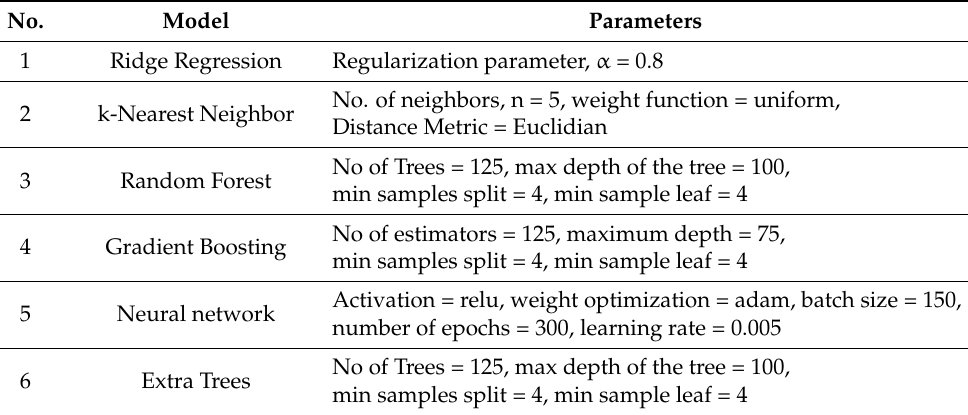
Table 1. Parameters for Machine Learning Techniques.